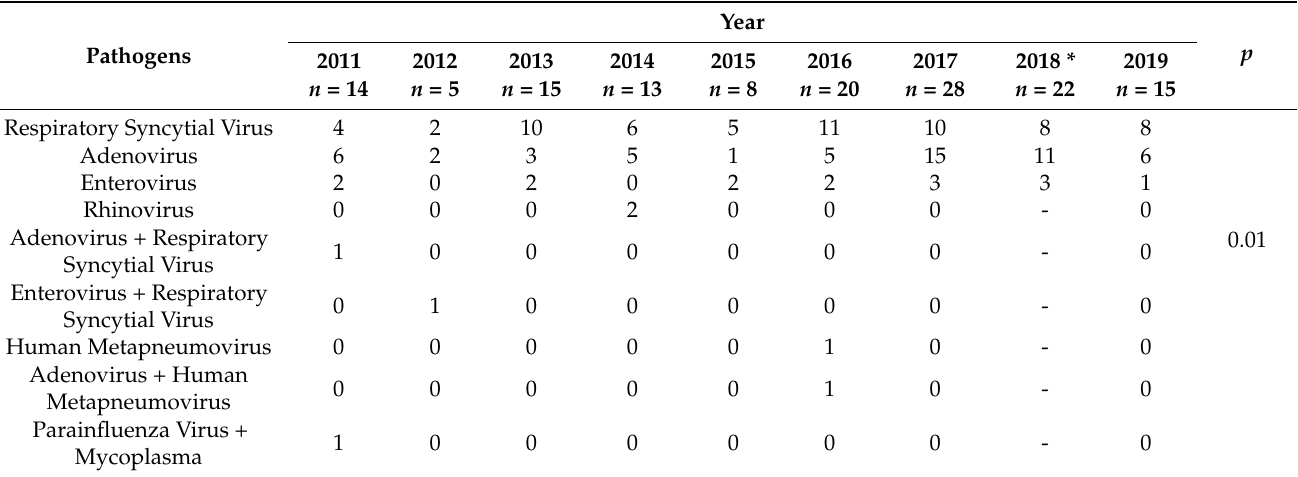
Table 3. The risk factors of non-influenza respiratory virus from analyzed URTI cluster data from 2011 to 2019, Taiwan.